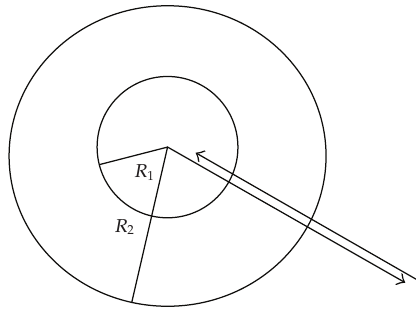
Figure 8: Schematic description of the impact